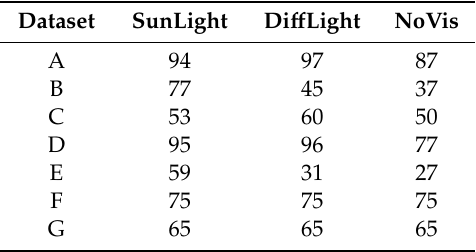
Table 2. Numbers of images belonging to di ff erent classes used in each